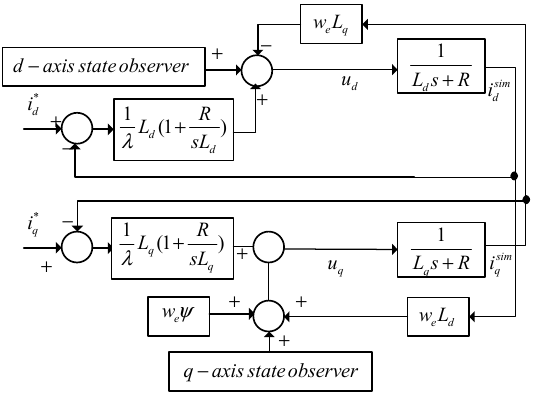
Figure 4. State observer based on internal model control.